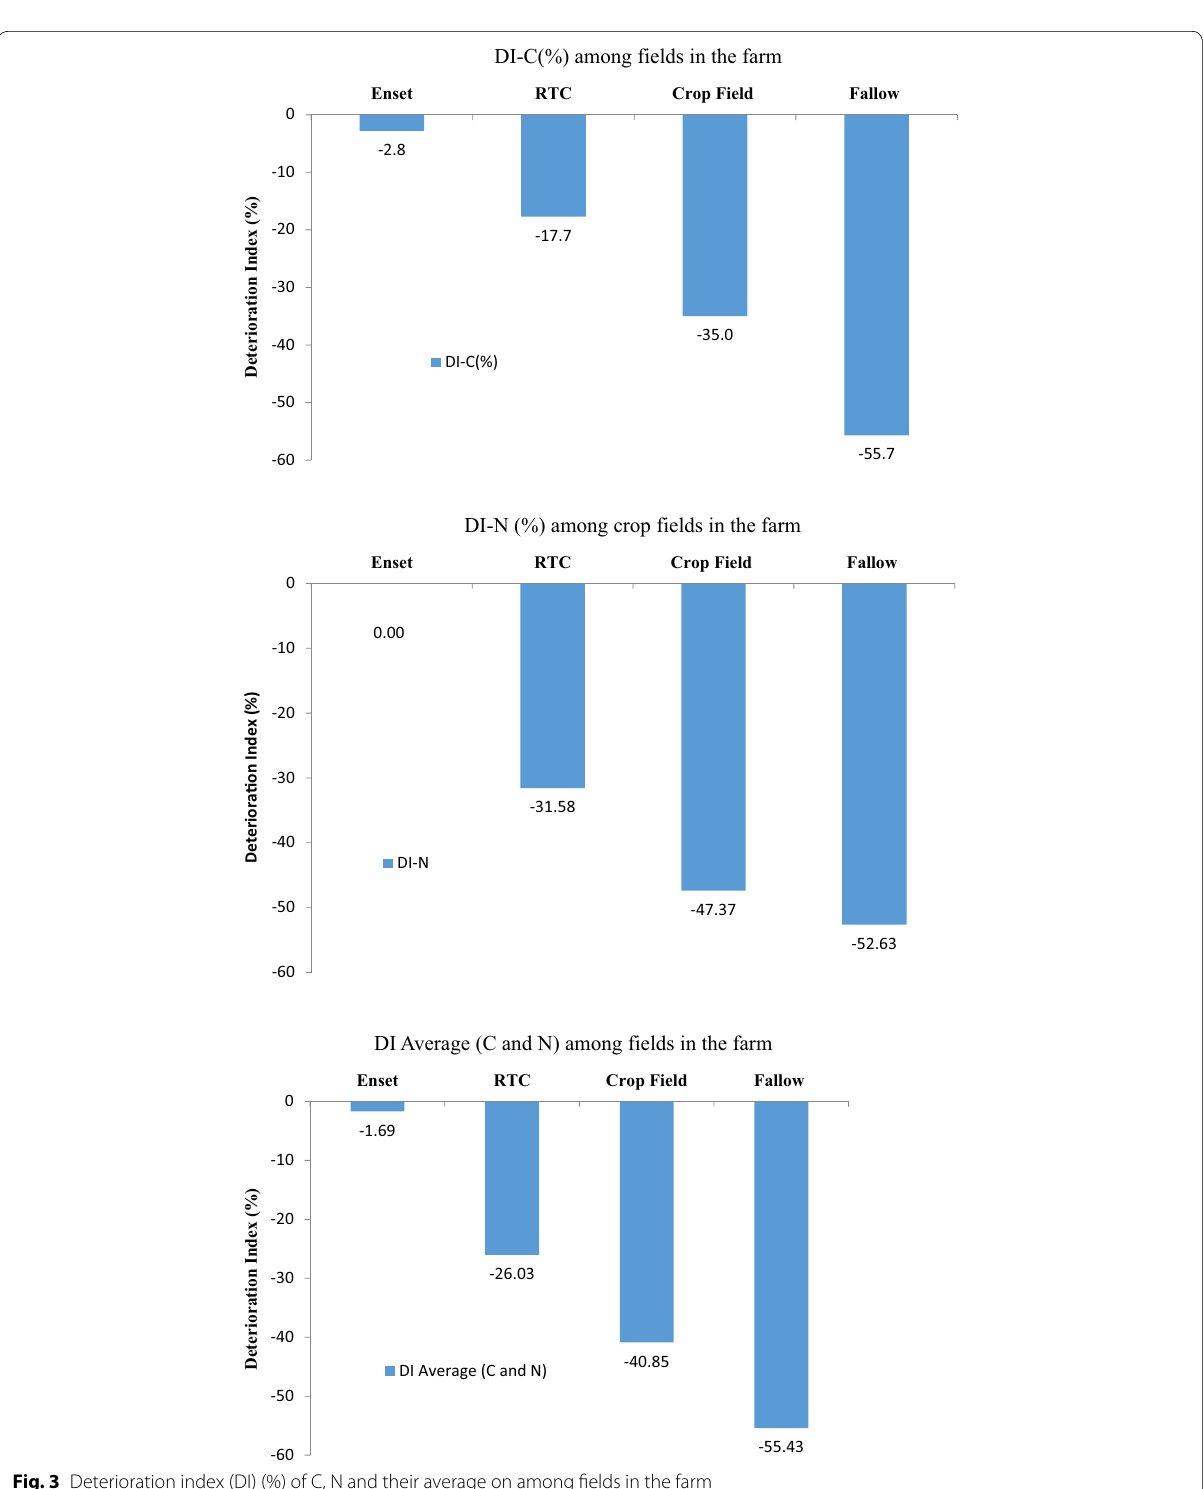
Fig. 3 Deterioration index (DI) (%) of C, N and their average on among fields in the